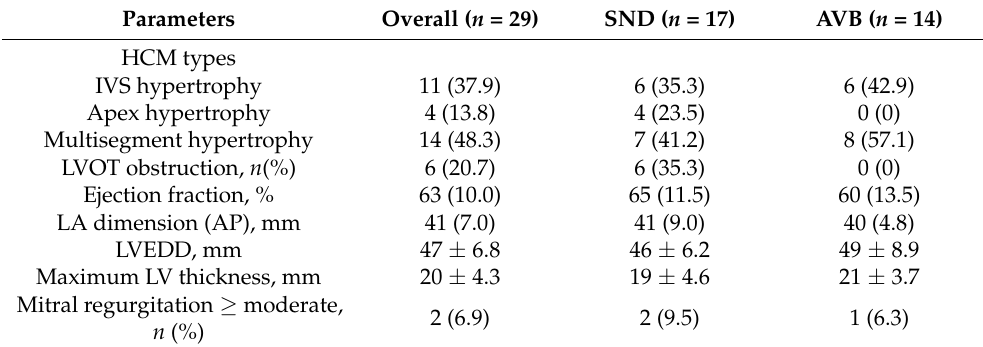
Table 2. Echocardiography parameters.